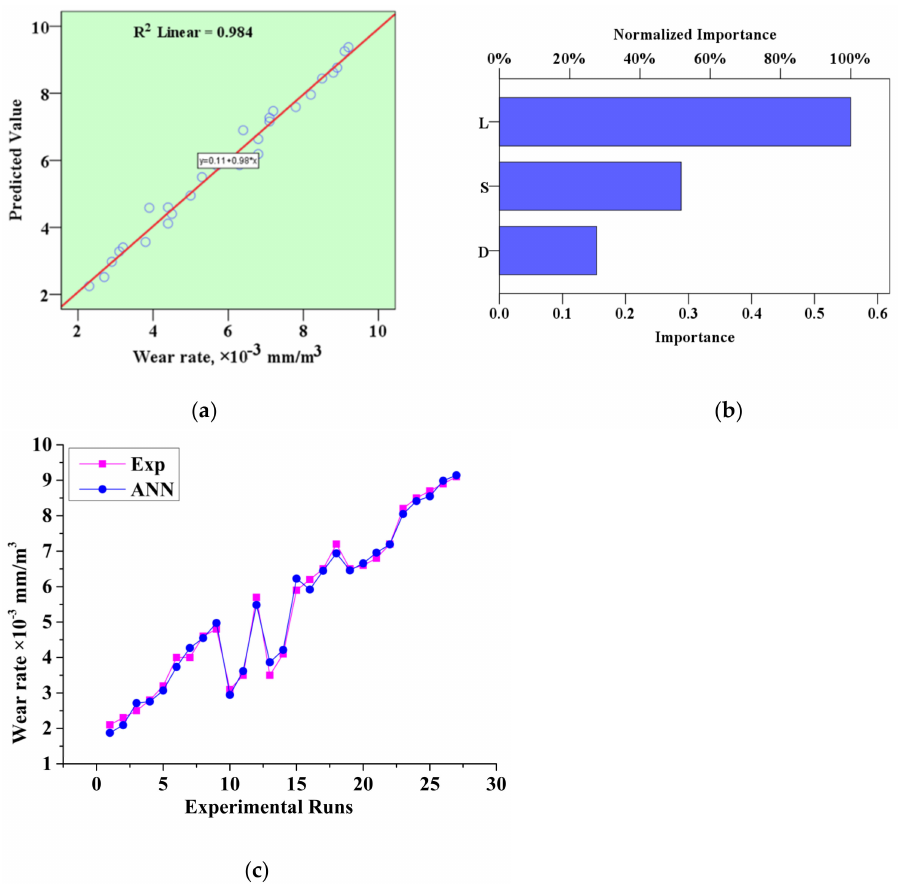
Figure 16. ANN analysis for sample A1: ( a ) experimental vs. predicted values; ( b ) normalized factor importance; and ( c ) error